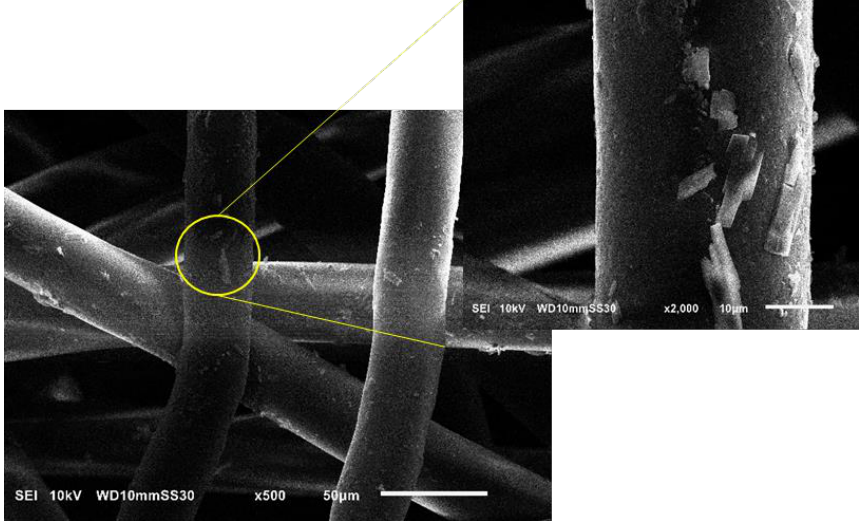
Figure 19. Scanning electron micrographs of PBS melt-electrospun microfibers containing 3% cur- cumin (C3). The inset image shows curcumin flaks distributed on the fibers.